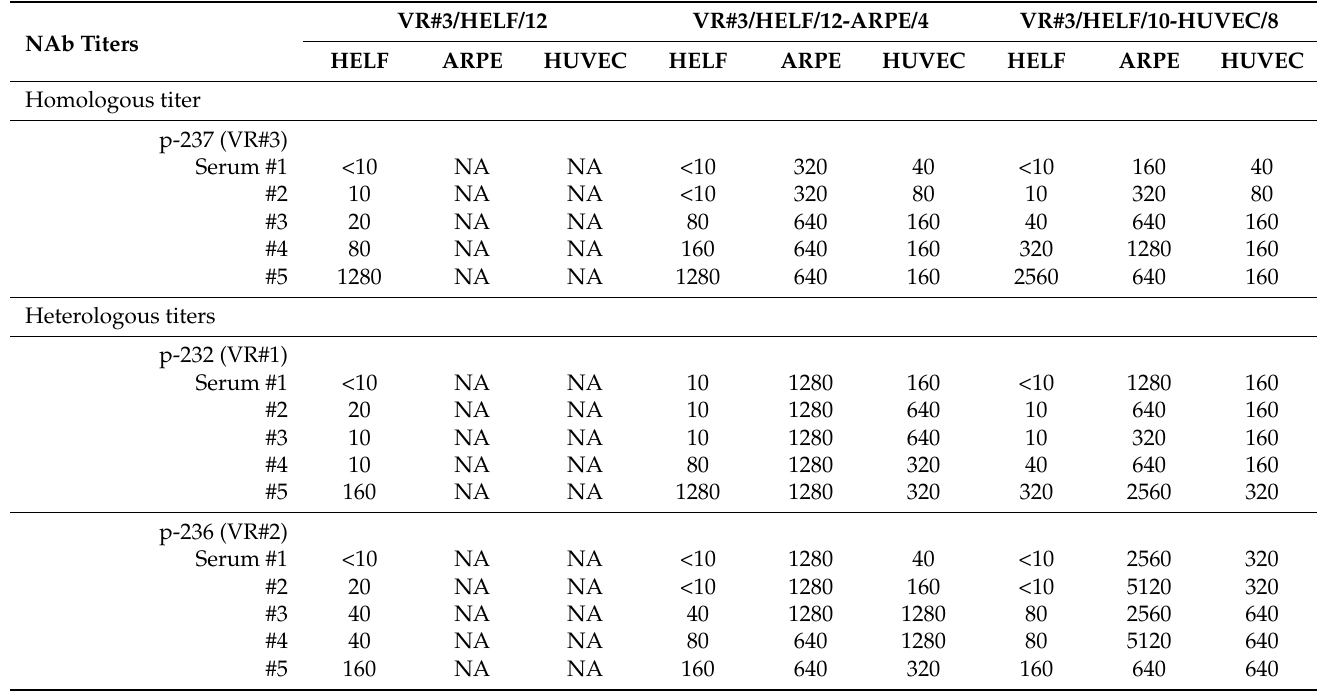
Table 3. Homologous and heterologous NAb titers of p-237 vs. VR#3 (homologous) and p-232 and p-236 vs. VR#3